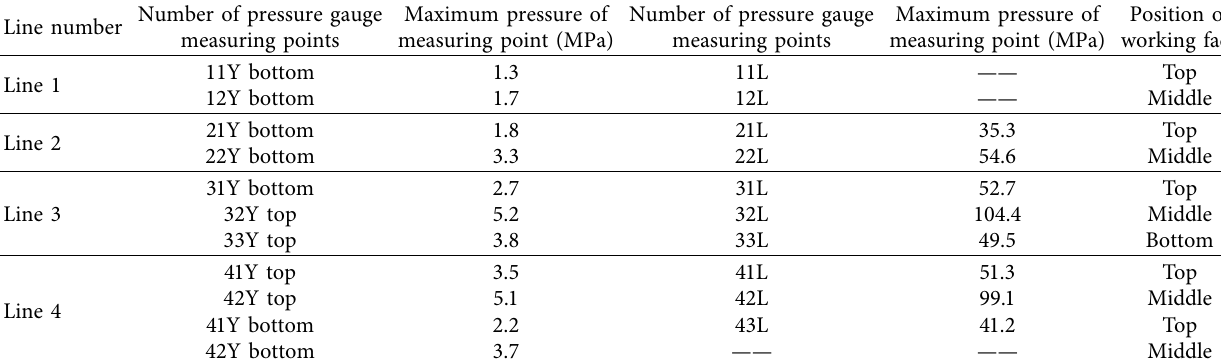
Table 5: Monitoring data of maximum stress and deformation of gangue filling